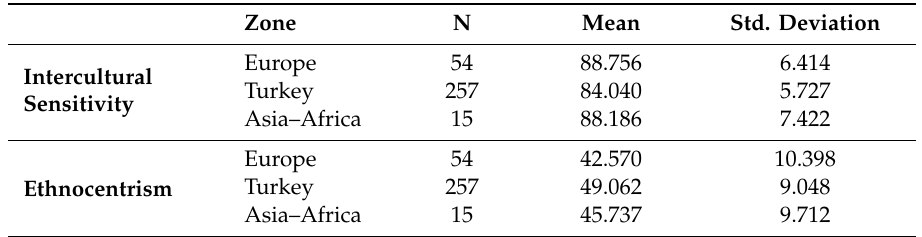
Table 10. Mean and standard deviation of students’ scores in the Intercultural Sensitivity Scale and the Ethnocentrism Scale according to the zone of